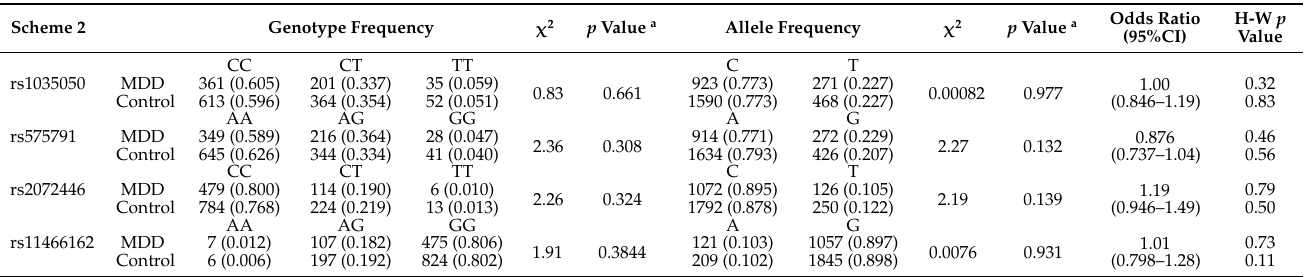
Table 4. Allele and genotype distribution of NGFR gene polymorphisms between MDD patients and healthy participants.